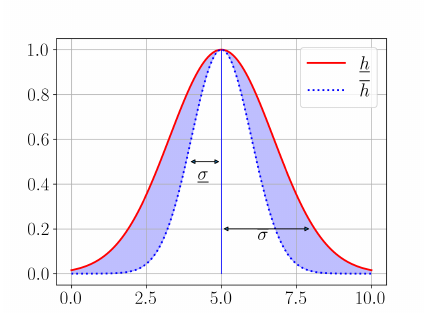
Figure 3. Gaussian membership function with uncertain